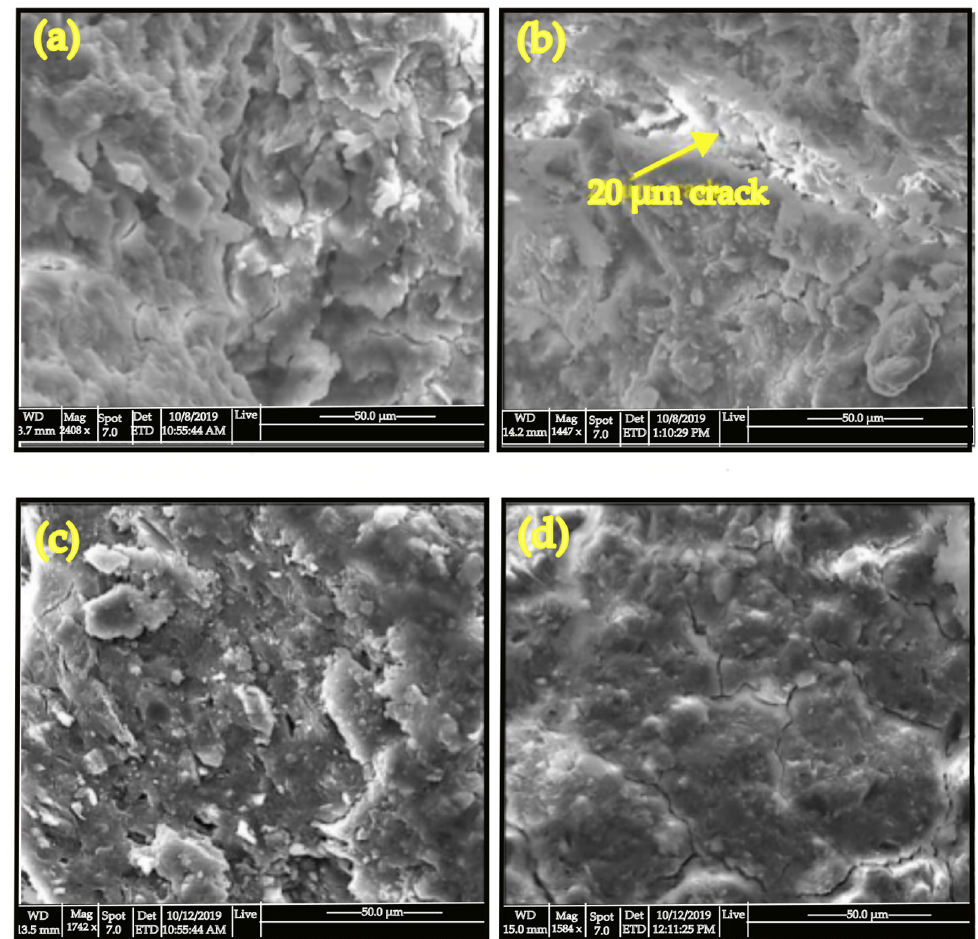
Figure 8. SEM images for ( a ) a room-temperature cured paste, ( b ) paste specimen after immersed in water, ( c ) paste with 10% NaOH and ( d ) paste with 10% CaO [79].